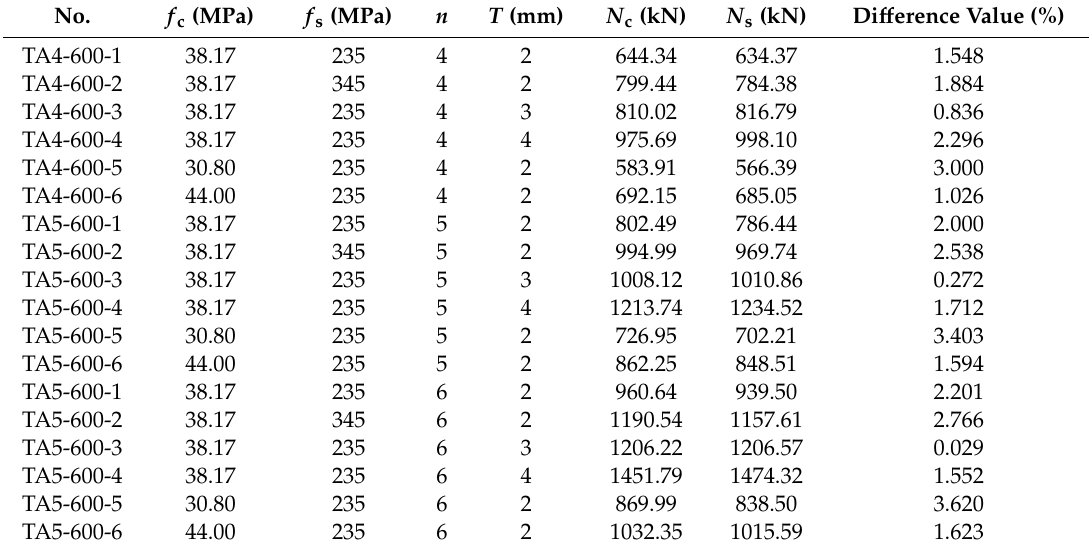
Table A1. Finite element simulation values under di ff erent